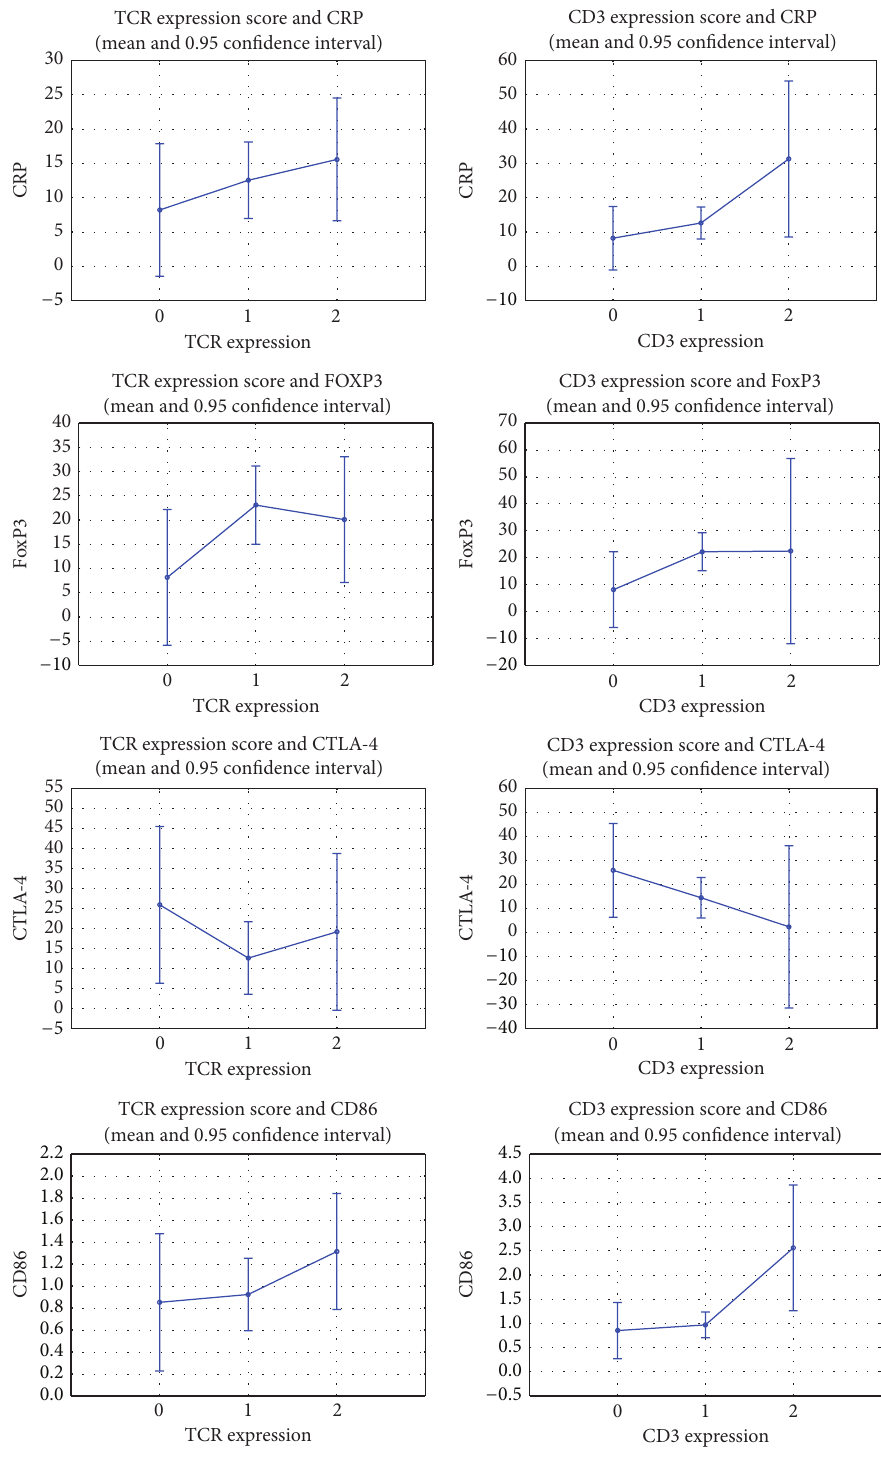
Figure 5: TCR and CD3 immunohistochemical grading score groups’ (0: ≤ 10% positive cells; 1: 11%–50%, 2: > 50% cells) mean and confidence values of CRP, FOXP3, CTLA-4, and CD86